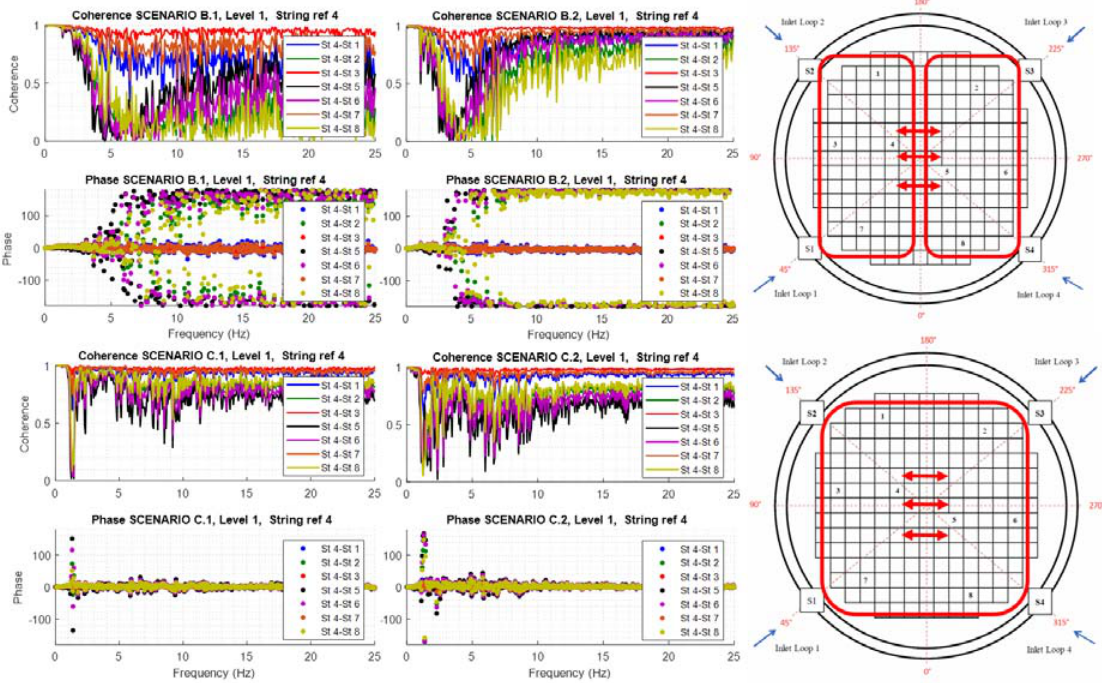
Figure 3: From left to right; Coherence and phase radial distribution. The upper figures correspond to Scenarios B (random vibrations) The lower figures correspond to Scenarios C (sinusoidal